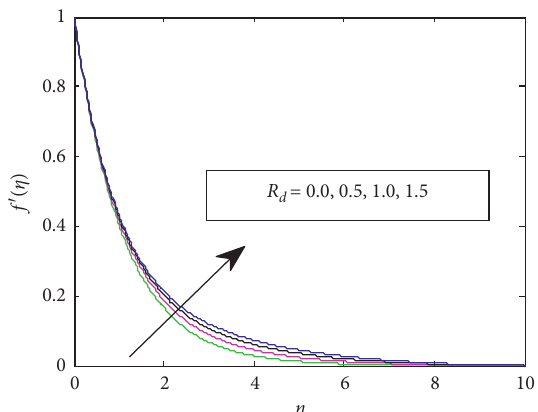
Figure 2: Velocity distribution for different values of radiation parameter.